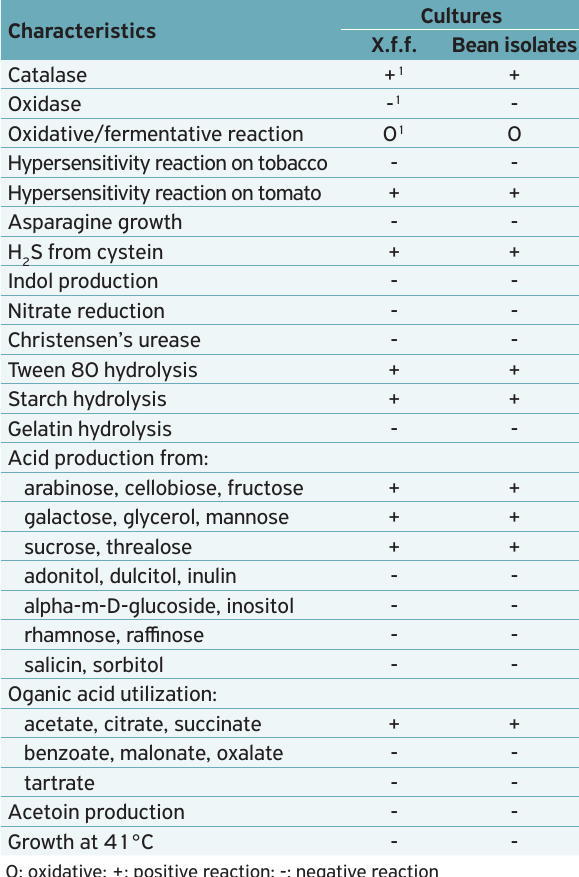
Table 1. Biochemical and physiological characteristics of Xanthomonas fuscans subsp. fuscans (X.f.f.) and the bean isolates.